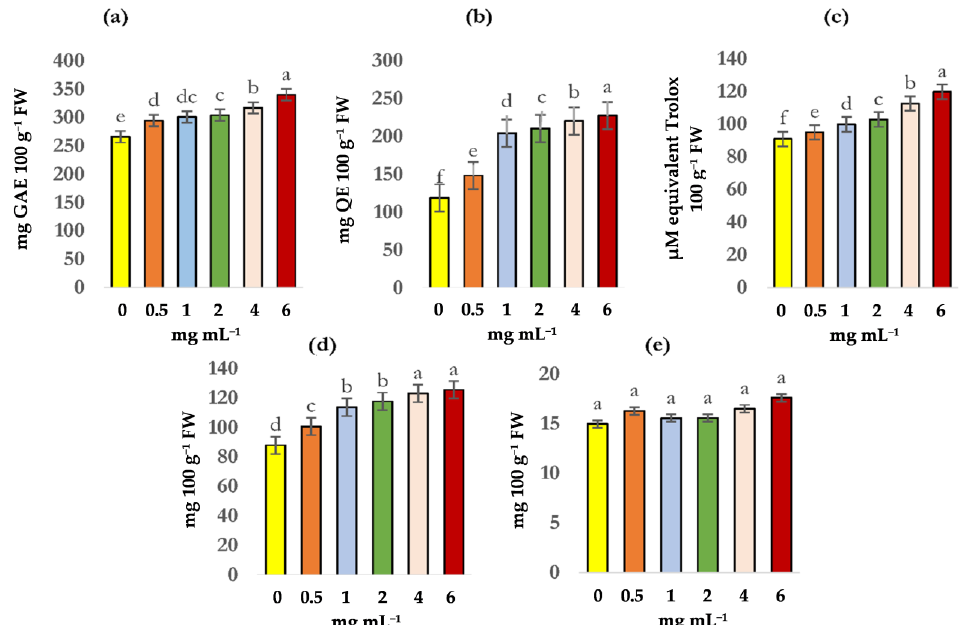
Figure 1. Content of total phenols ( a ), flavonoids ( b ), antioxidant capacity ( c ), chlorophyll ( d ), and vitamin C ( e ) due to the effect of different doses of CuO-NPs applied in lettuce. Data shown as mean ± standard deviation (SD). Different letters indicate a significant difference ( p ≤ 0.05) according to Tukey’s test. GAE = gallic acid equivalents; QE = quercetin; FW = fresh weight.